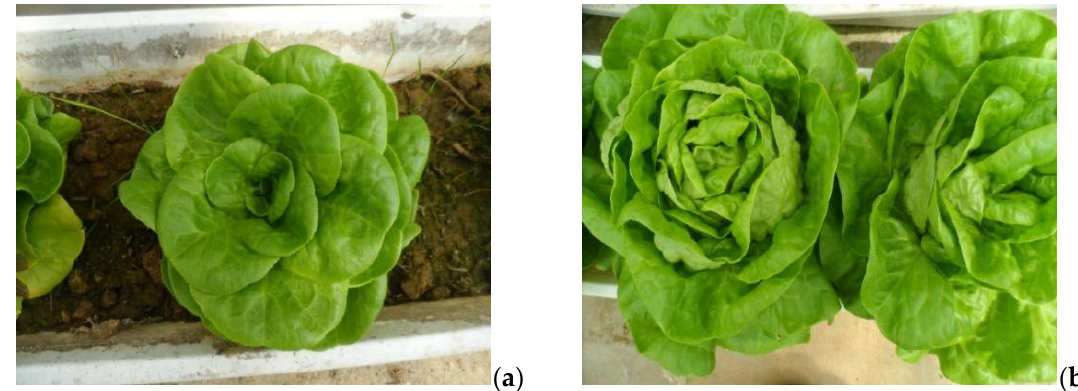
Figure 1. Lettuce growth in fifth week of the experiment: ( a ) on control soil without compost / biochar amendments (SC); and ( b ) on soil with 5% biochar + 5% compost (5BC + 5C).